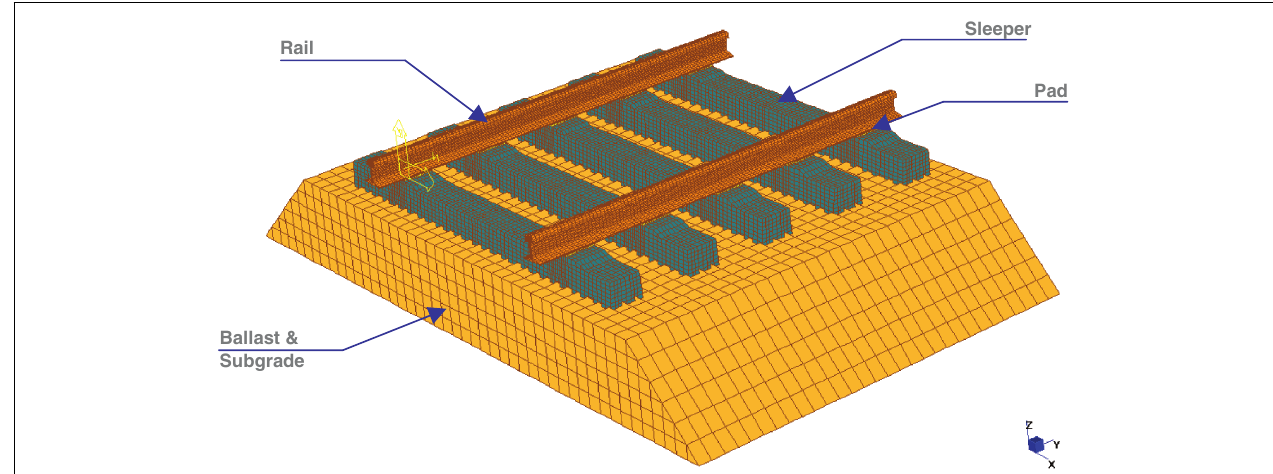
FIGURE 1 |Typical components of railway tracks